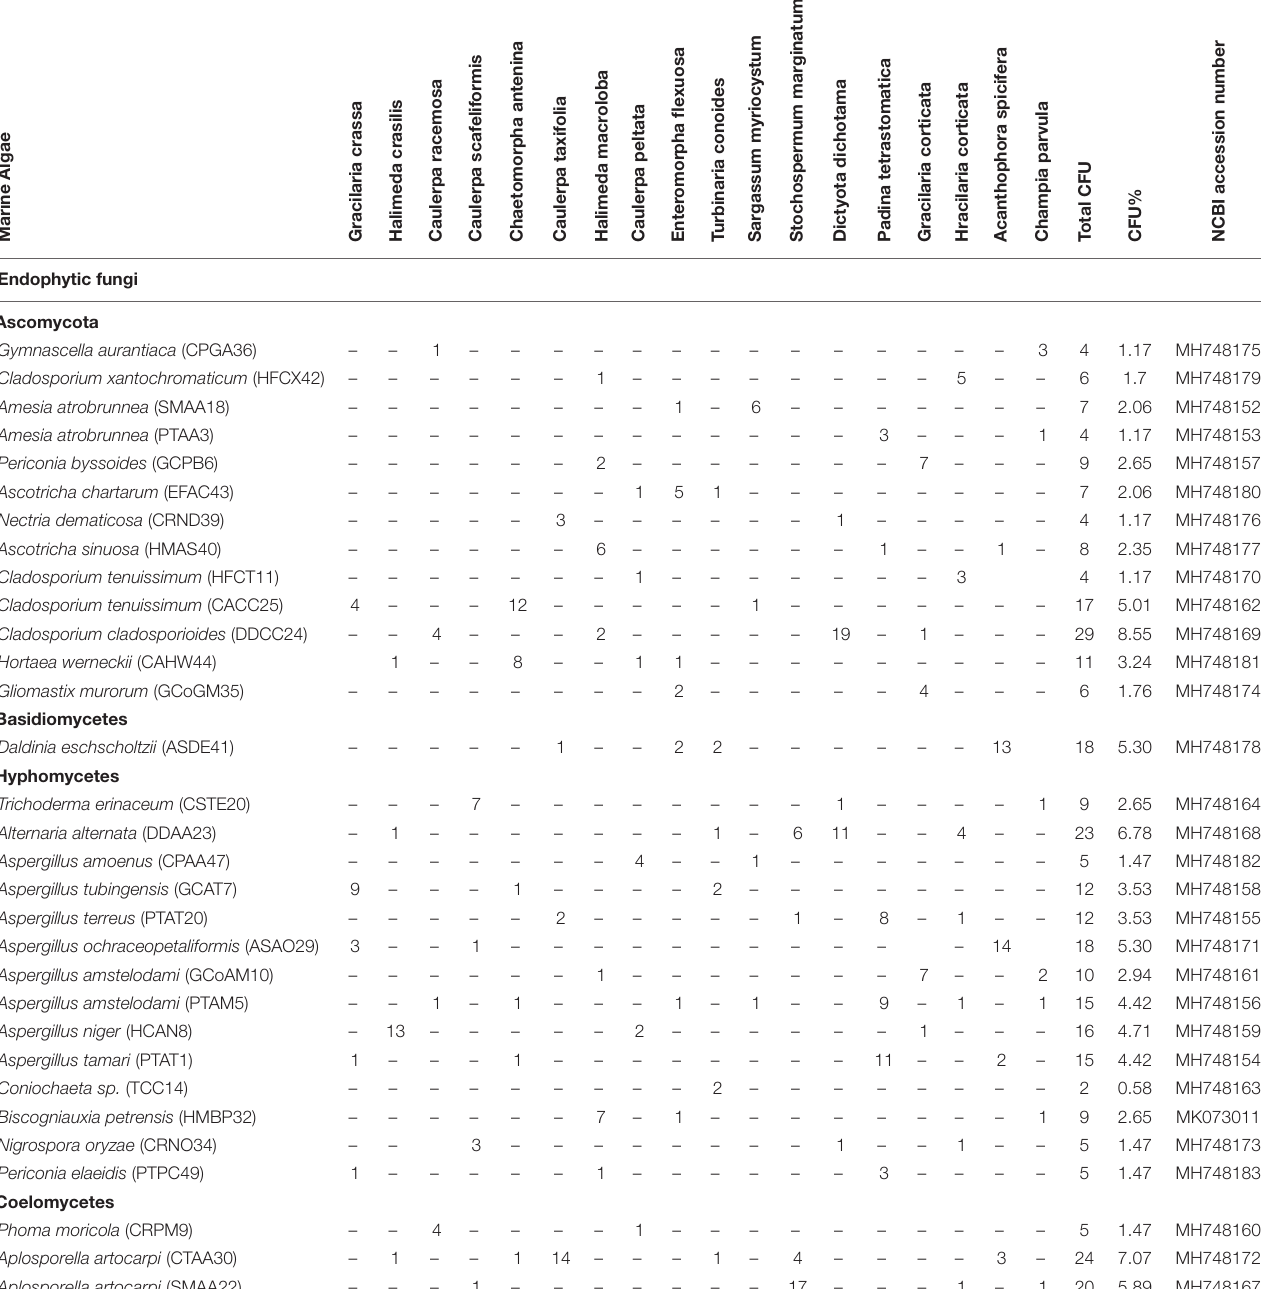
TABLE 2 | Host algae and their respective endophytic fungi with CFU and NCBI accession